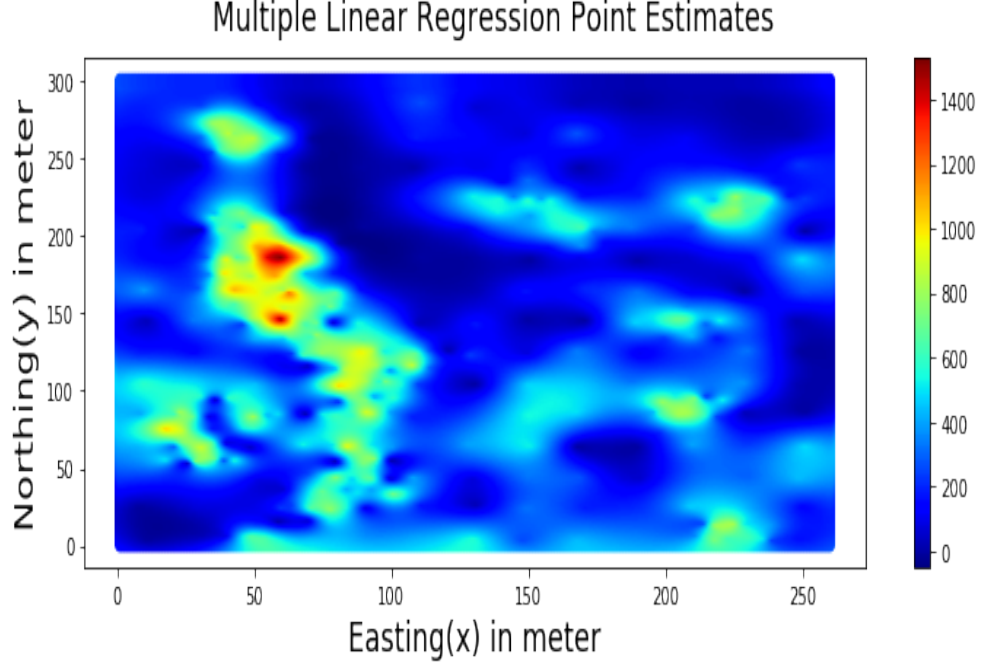
Figure 9. Multiple Linear Regression Point Estimates for Walkerlake dataset.